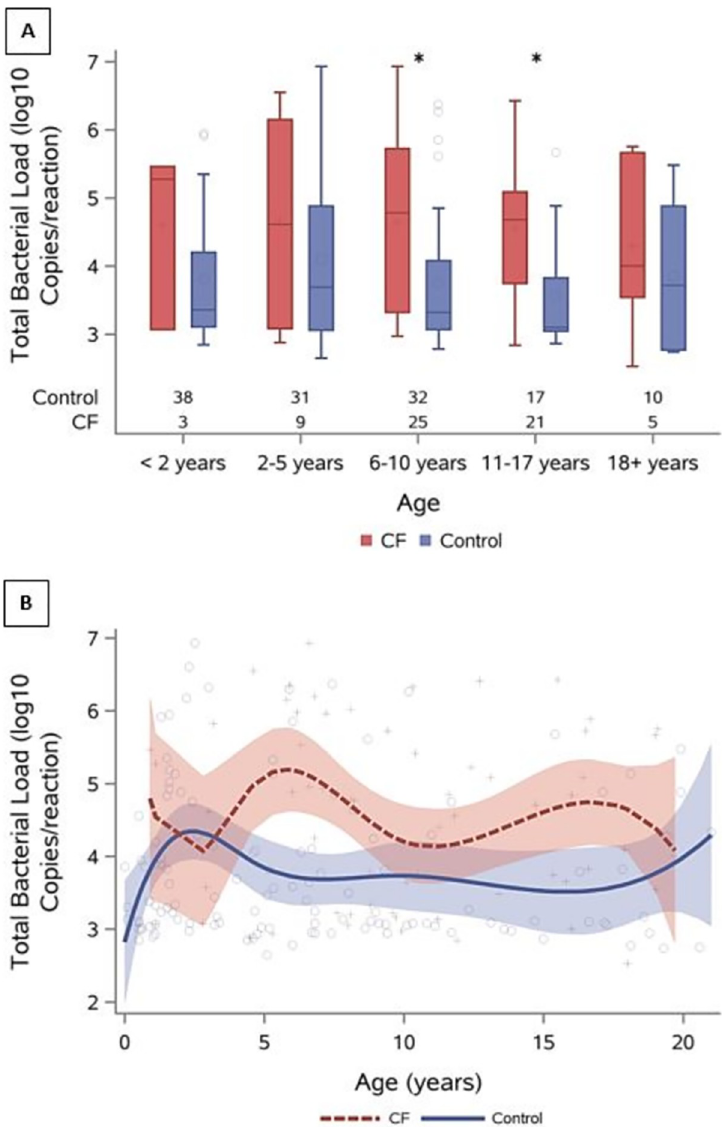
B spline fitting (solid line) and 95% confidence intervals (shaded areas). On average BALF samples from CF subjects have higher TBL compared to DC samples, this is more pronounced during early school age and